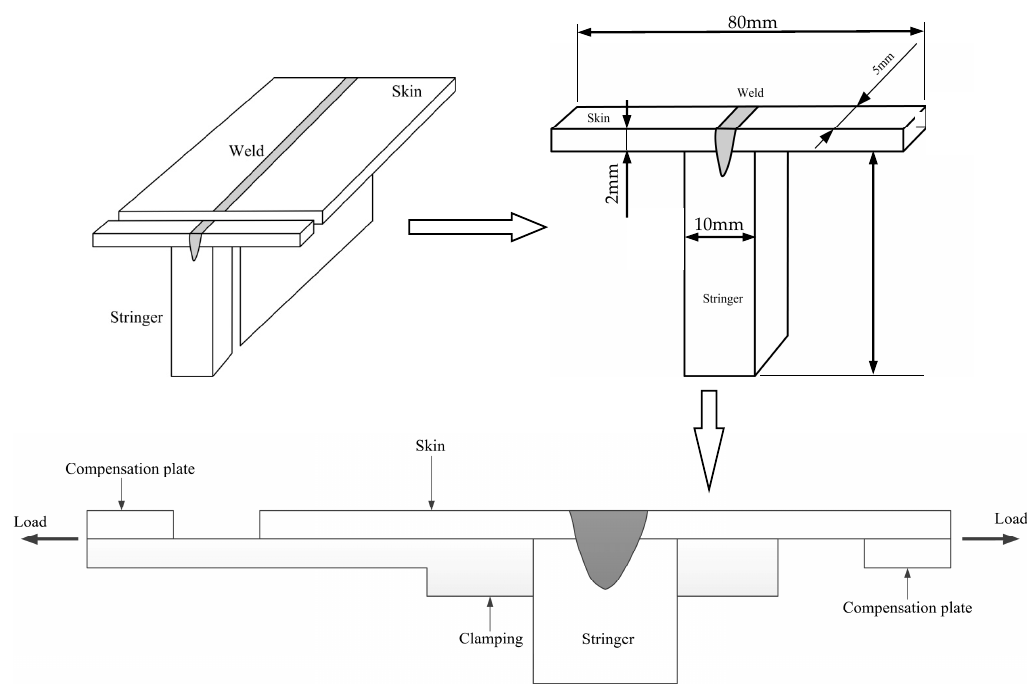
Figure 2. Schematic diagram of the specimen preparation and assembly for the tensile shear tests.